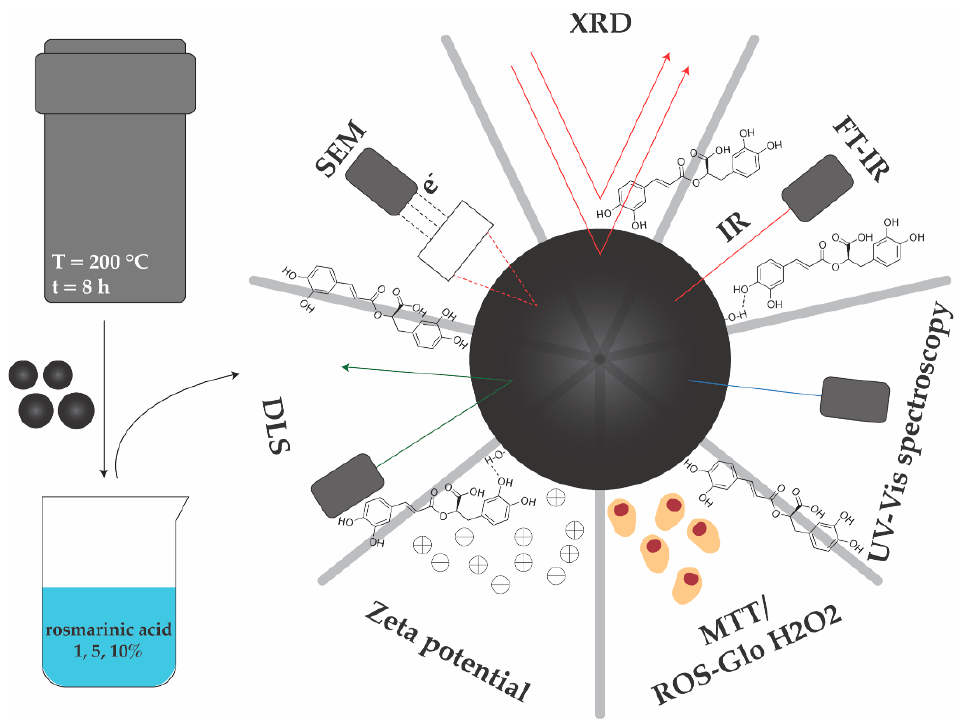
Figure 1. Schematic representation of the experimental design, involving the synthesis and characterization methods employed.